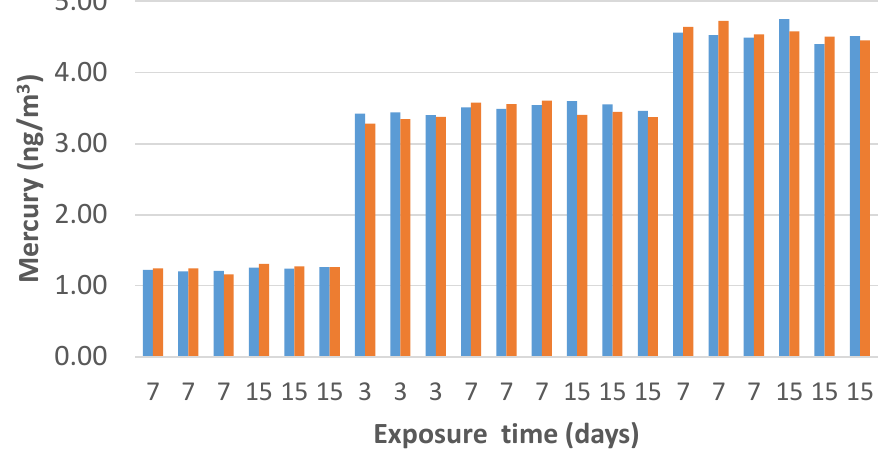
Figure 13. Comparison between the PAS estimated concentration using the experimental sampling rate (red bar) and the measured values by the vapor mercury analyzer (blue bar).